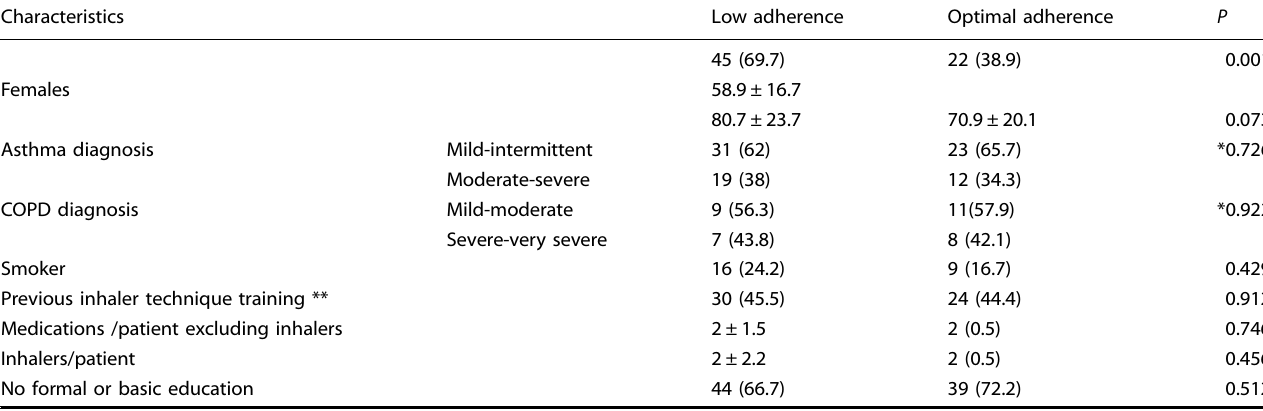
Table 5. Relation of the low and optimal adherence and baseline characteristics of the patients with COPD and asthma. Characteristics